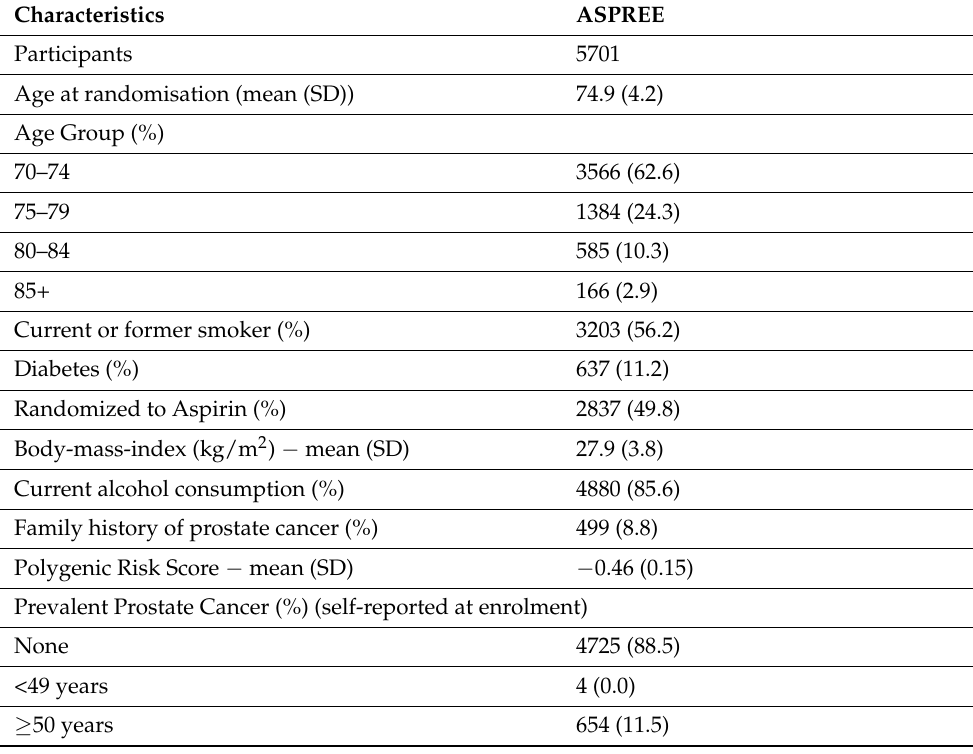
Table 1. Baseline characteristics of the included ASPREE male